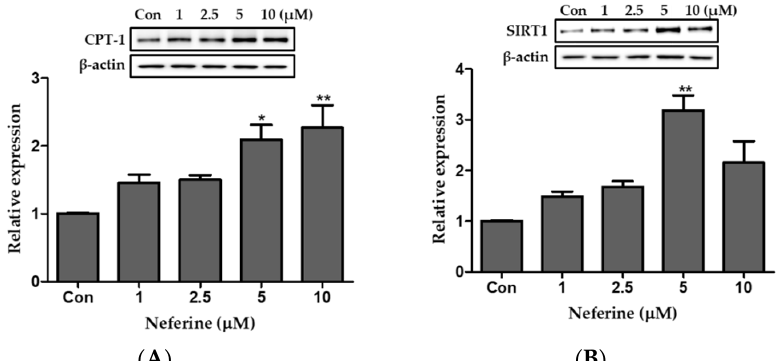
Figure 5. Effect of neferine on the expression of the protein involved in fatty acid oxidation. Western blotting was carried out to analyze the protein expression of ( A ) CPT-1 and ( B ) SIRT1 following normalization to β -actin. * p < 0.05, ** p < 0.01, and *** p < 0.001 vs. Con. All data are presented as mean ± SD, and experiments were performed at least thrice. The positive control (Con) was differentiated 3T3-L1 cells treated with adipocyte differentiation cocktail.